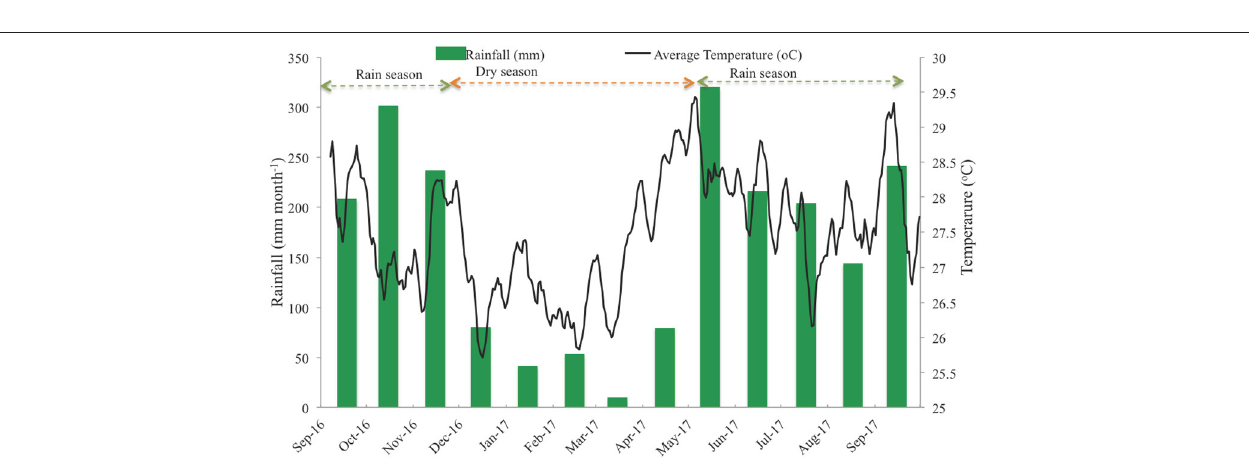
FIGURE 2 | Monthly average temperature and monthly average precipitation in Can